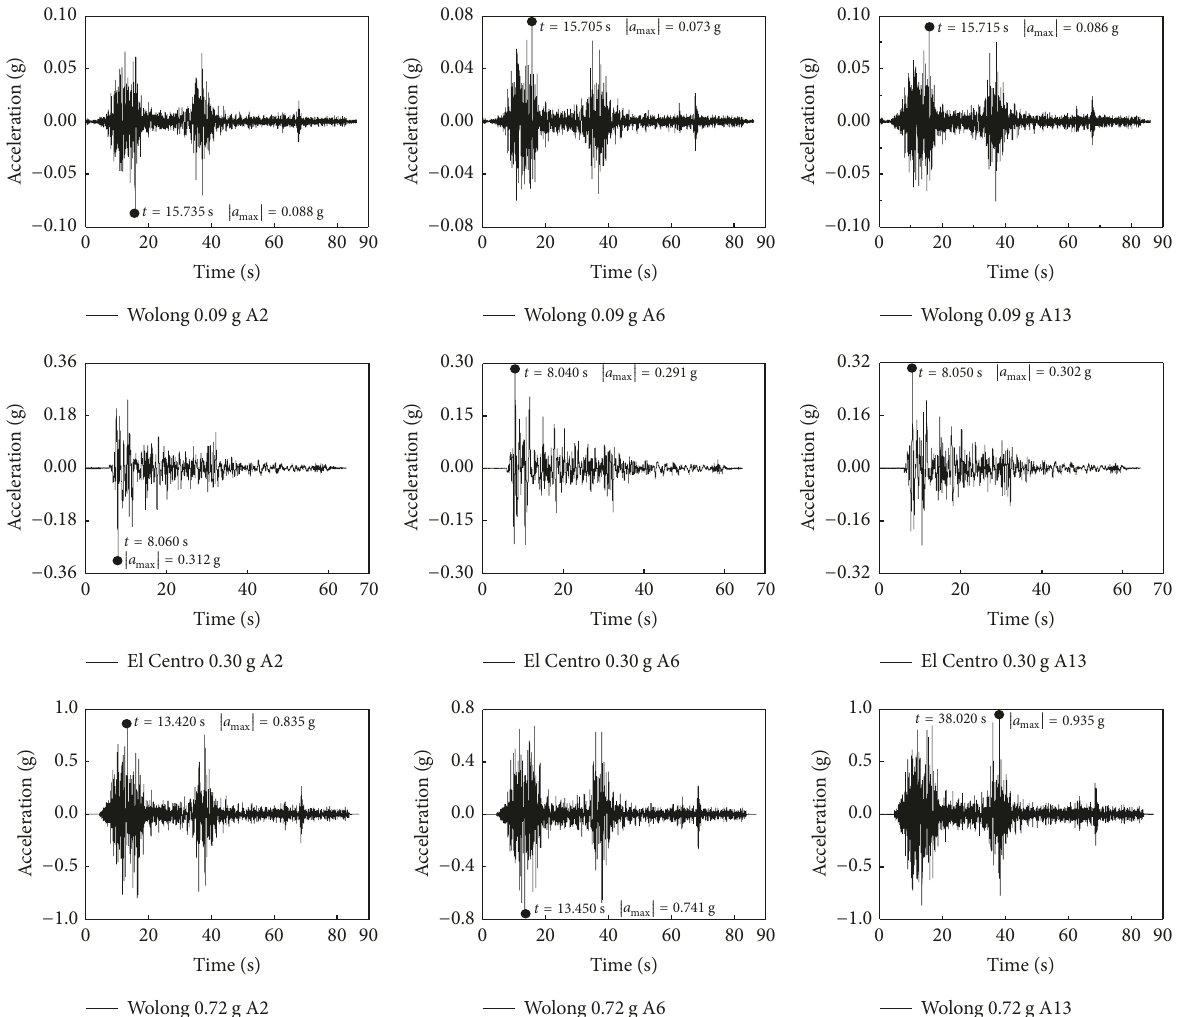
Figure 11: Acceleration time histories of the model structure under different input